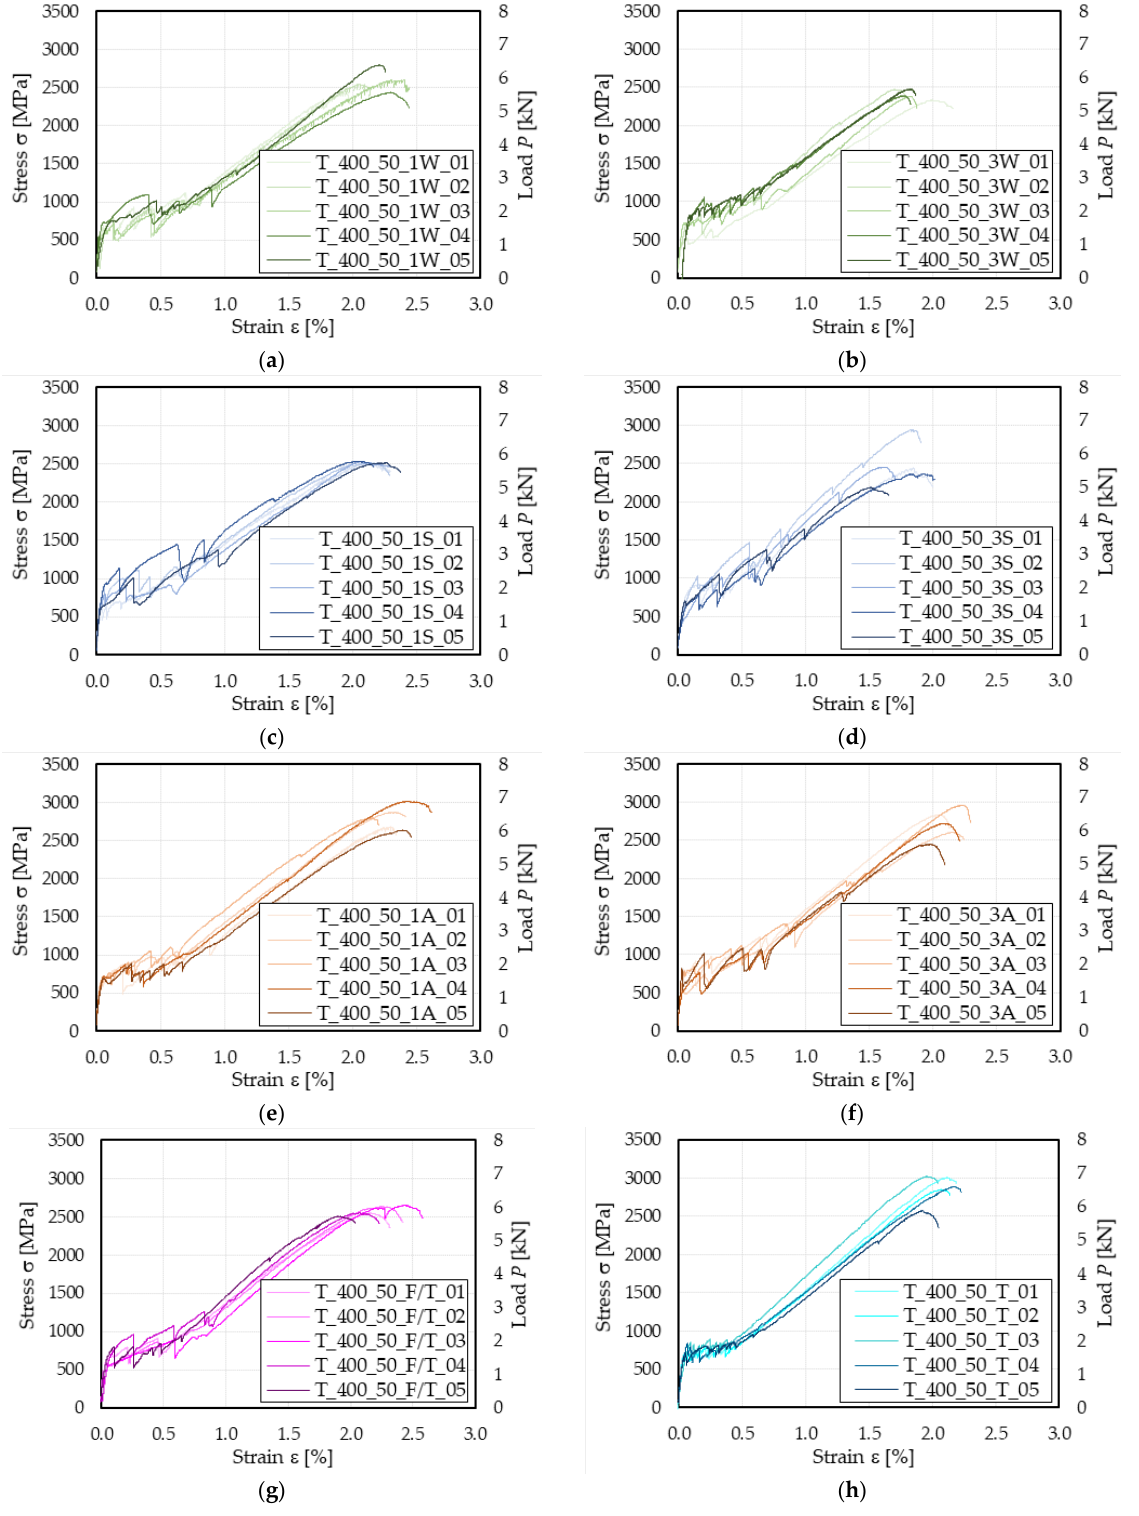
Figure 3. Results of conditioned FRCM coupons: ( a ) hygrothermal, 1000 h; ( b ) hygrothermal, 3000 h; ( c ) saline, 1000 h; ( d ) saline, 3000 h; ( e ) alkaline, 1000 h; ( f ) alkaline, 3000 h; ( g ) freeze–thaw cycles; ( h ) dry-heat (100 °C).